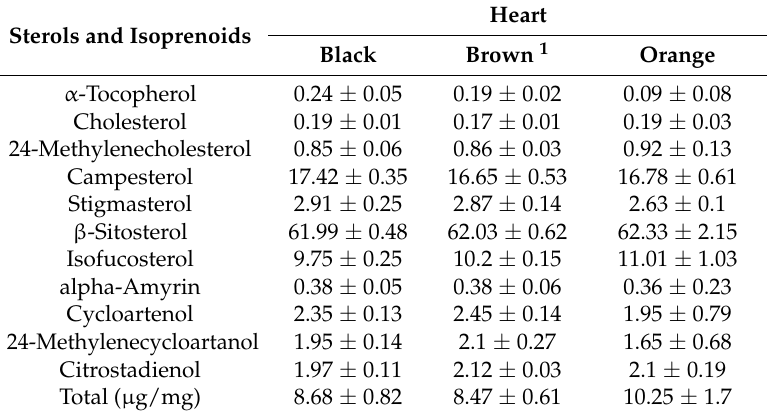
Table 3. Phytosterol and Isoprenoid Composition of Arachis hypogaea Seed Kernels of Different Classes.